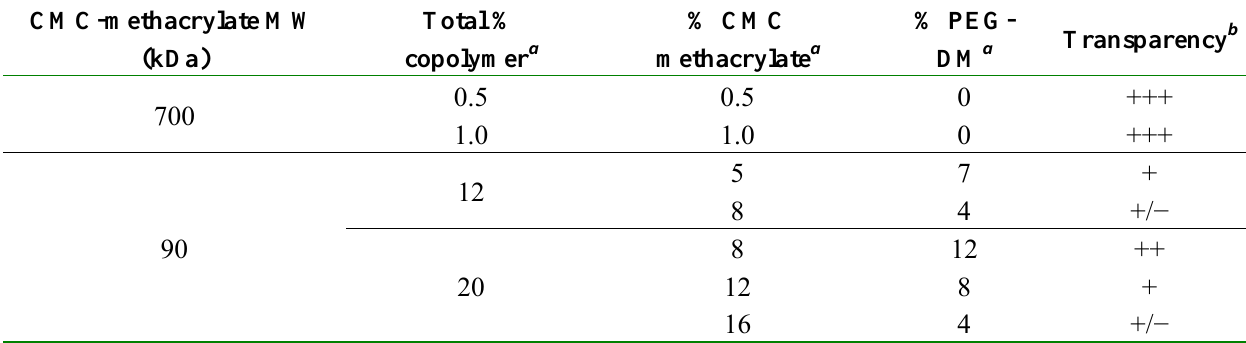
Table 1. Compositions of CMC-methacrylate gels and their relative transparency. CMC-methacrylate